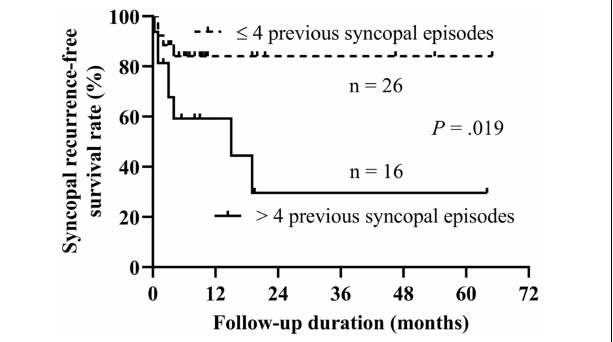
FIGURE 4 | Kaplan–Meier curve analysis of the syncopal recurrence-free survival rate between patients with > 4 previous syncopal episodes and with ≤ 4 previous sycopal episodes. The y -axis represents the survival rate for non-recurrence of syncope; the x -axis represents follow-up duration. The recurrence-free survival rate of syncope in patients with > 4 previous syncopal episodes before treatment was significantly lower than that of patients with ≤ 4 episodes ( P = 0.019 at the log-rank